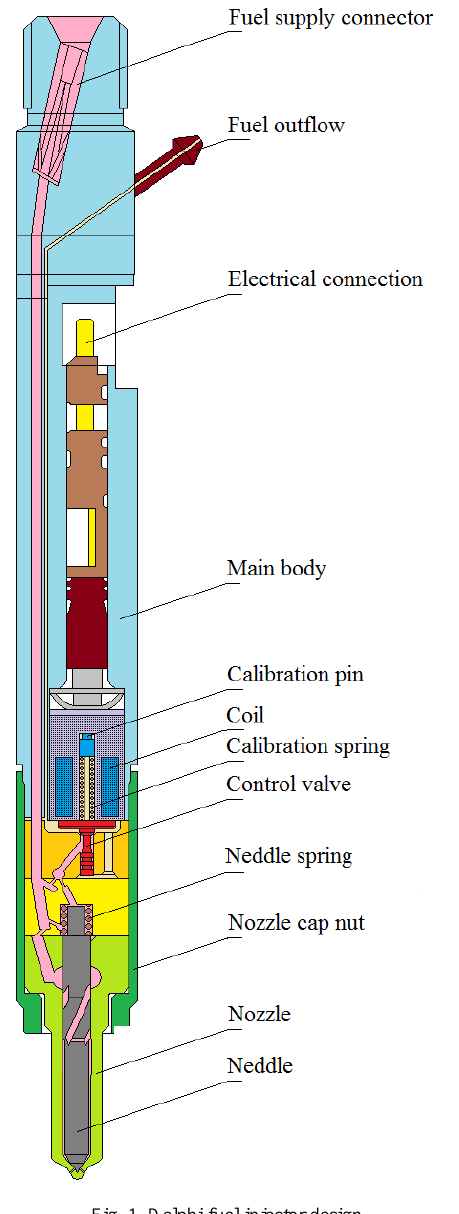
Fig. 1. Delphi fuel injector